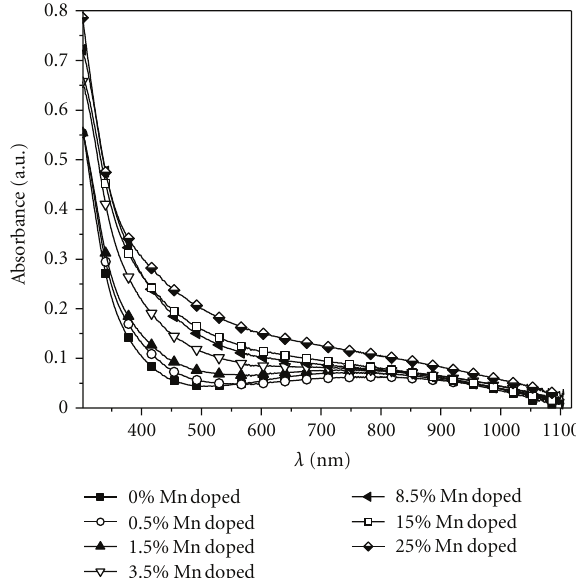
Figure 2: Absorption spectra of pure, 0.5%, 1.5%, 3.5%, 8.5%, 15%, and 25% doped TiO 2